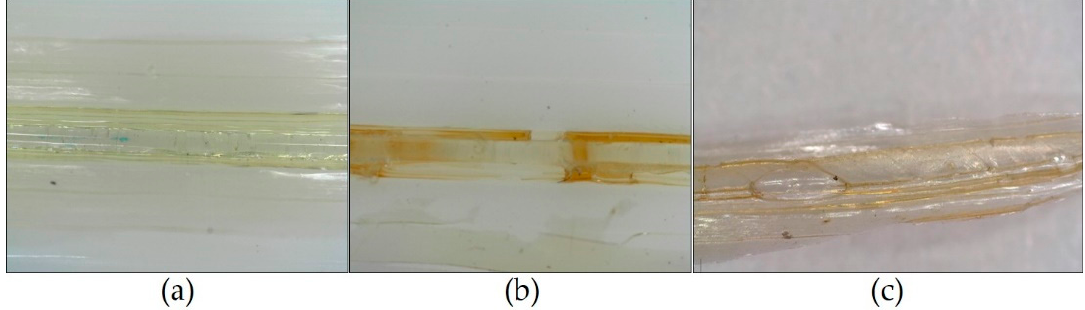
Figure 2. Microscopic photos of three samples produced with different chitosan solutions: ( a ) LMW chitosan, 5% wt. in 1% aqueous acetic acid; ( b ) LMW chitosan, 5% wt. in 2% aqueous acetic acid; ( c ) HMW chitosan, 5% wt. in 1% aqueous acetic acid. Table 1. List of the